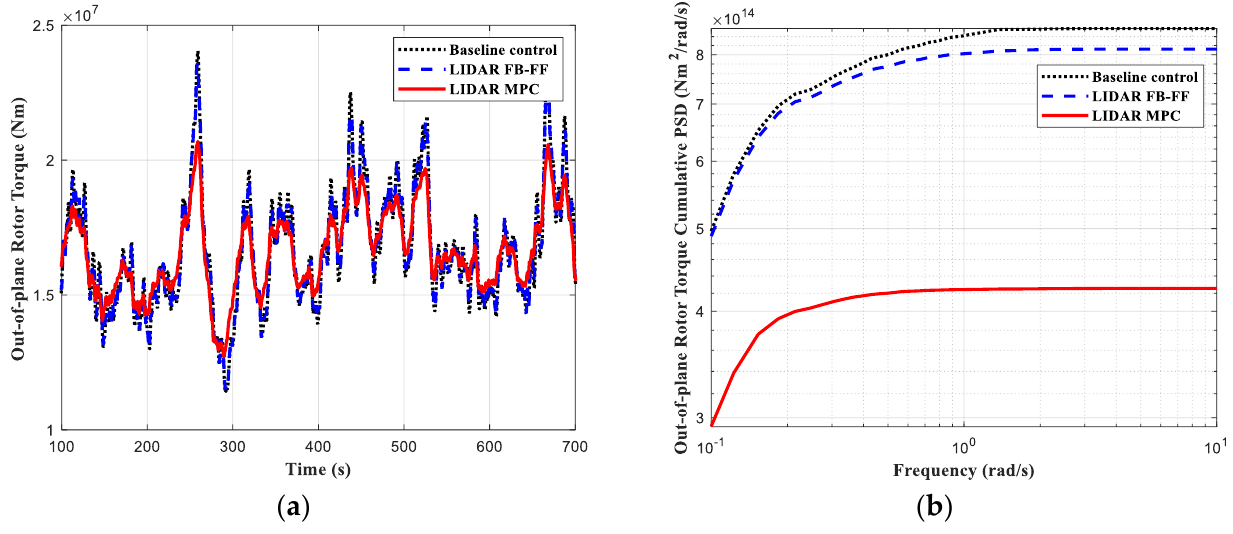
Figure 12. Out-of-plane rotor torque: ( a ) time profiles; ( b ) cumulative PSD (for wind speed with 15% turbulence intensity).